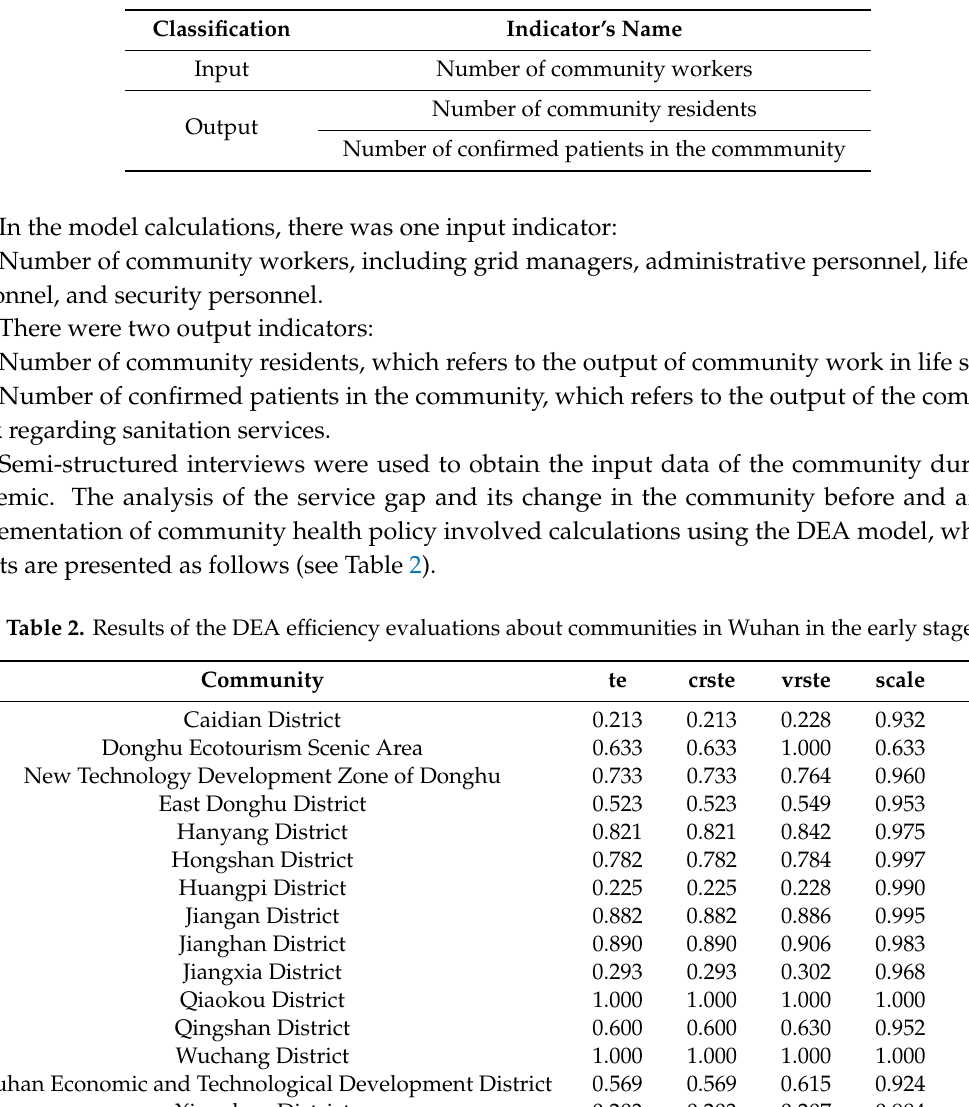
Table 1. Indicators of the data envelopment analysis (DEA) model.